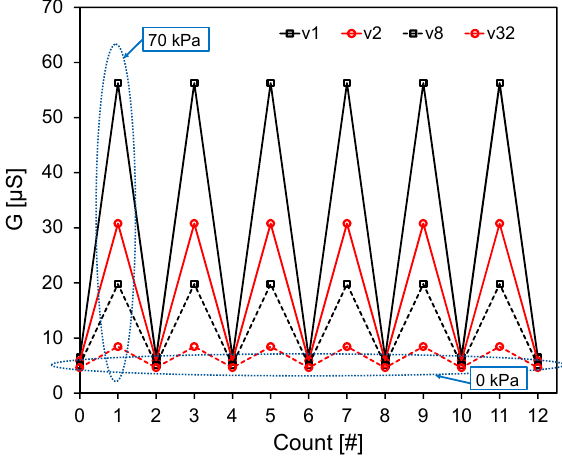
Figure 15. Conductance measured at the beginning (0 kPa) and at the end (70 kPa) of six consecutive monotonic loading tests repeated at different crosshead speeds.